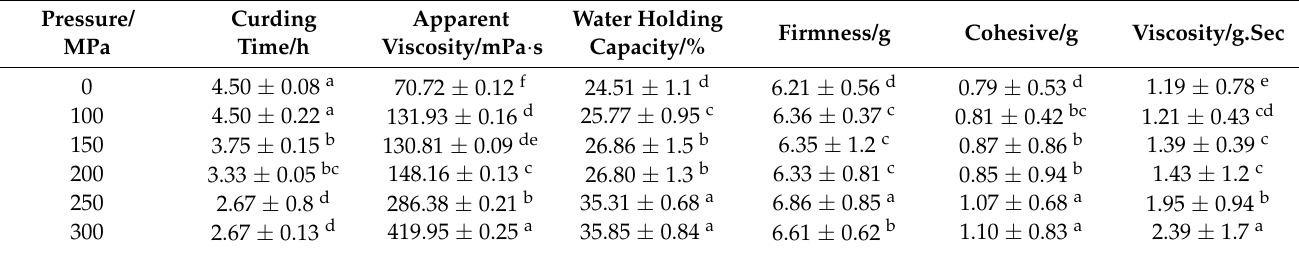
Table 4. Coagulation properties of skimmed milk after different pressure